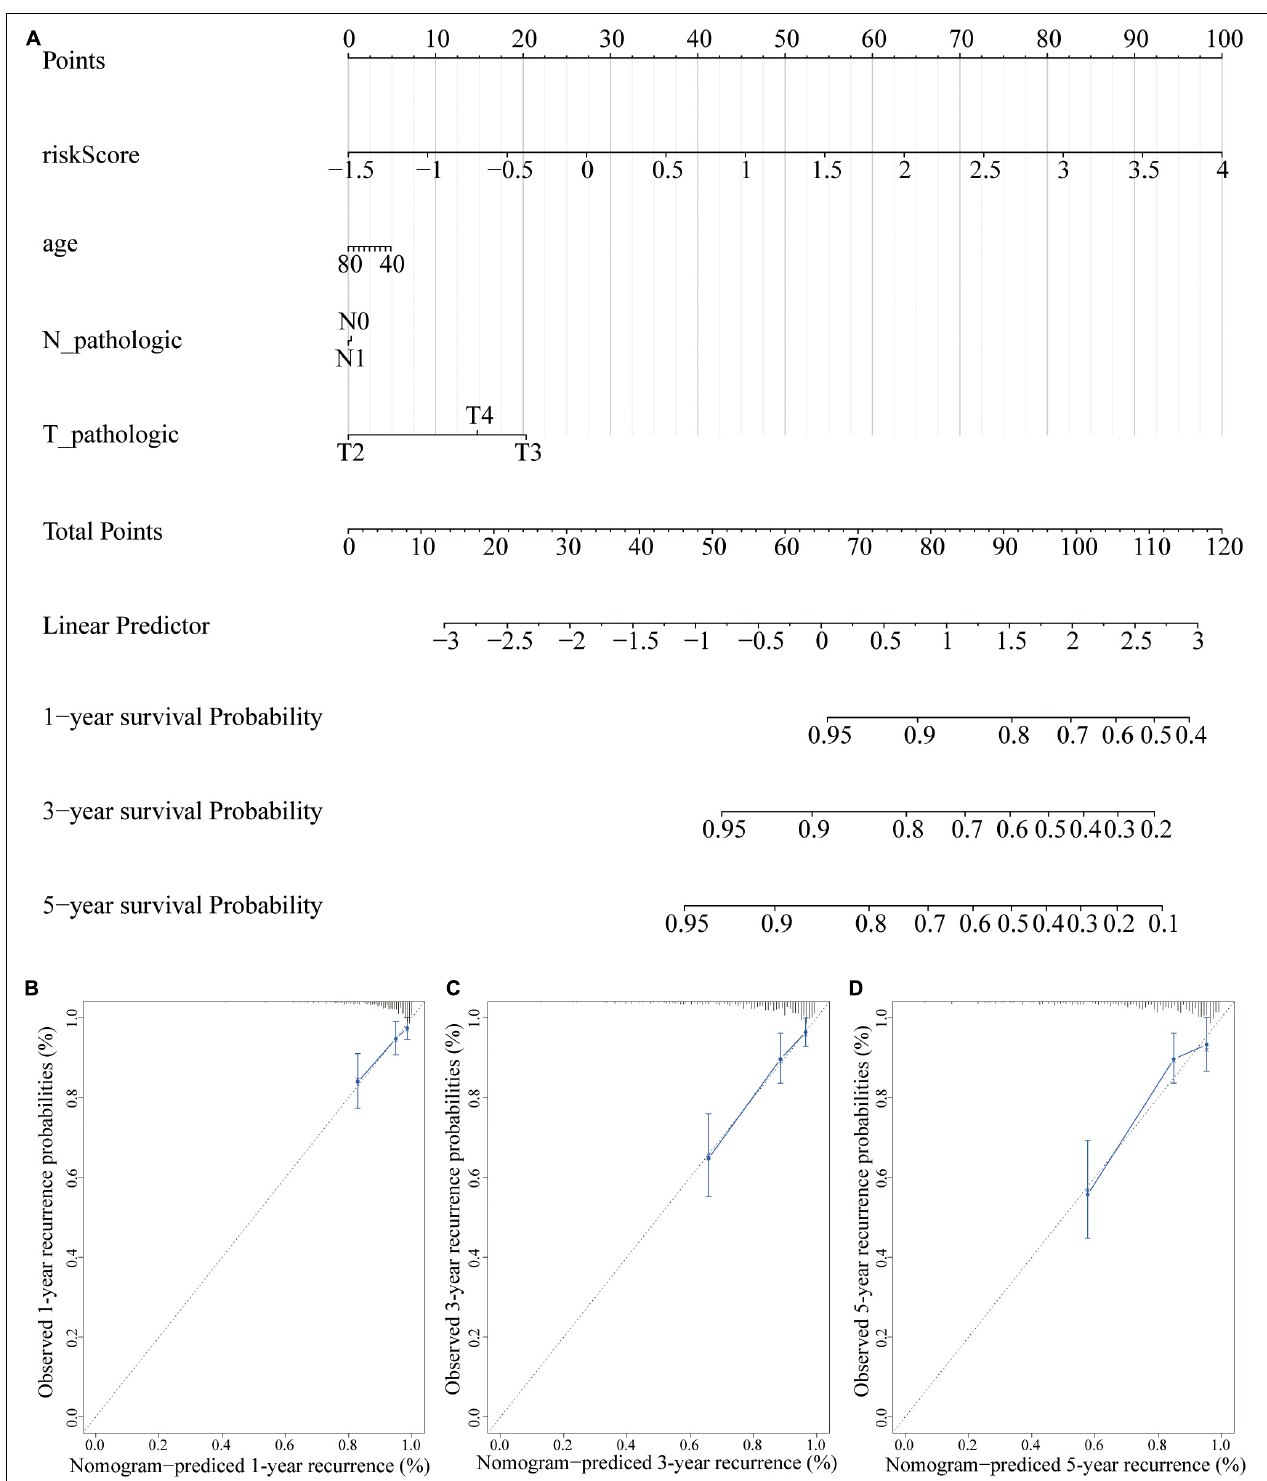
FIGURE 11 | A nomogram for recurrence prediction. (A) Nomogram based on the signature and clinicopathological features. (B) Calibration plot showing that nomogram-predicted 1-year recurrence probabilities corresponded to the actual observed 1-year recurrence probabilities; (C) Calibration plot showing that nomogram-predicted 3-year recurrence probabilities corresponded to the actual observed 3-year recurrence probabilities; (D) Calibration plot showing that nomogram-predicted 5-year recurrence probabilities corresponded to the actual observed 5-year recurrence probabilities.